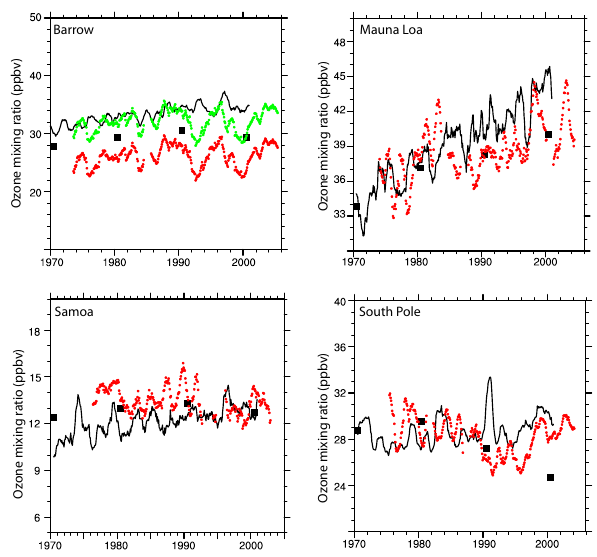
Fig. 6. Time evolution (1970–2009) of surface ozone (12-month running mean) at a variety of sites. Observations are in red, CAM- chem results are in black (solid line) and G-PUCCINI results are in black (solid squares). A constant value of 6ppbv was added to the Barrow observations to take into account model deficiencies; this is shown as green